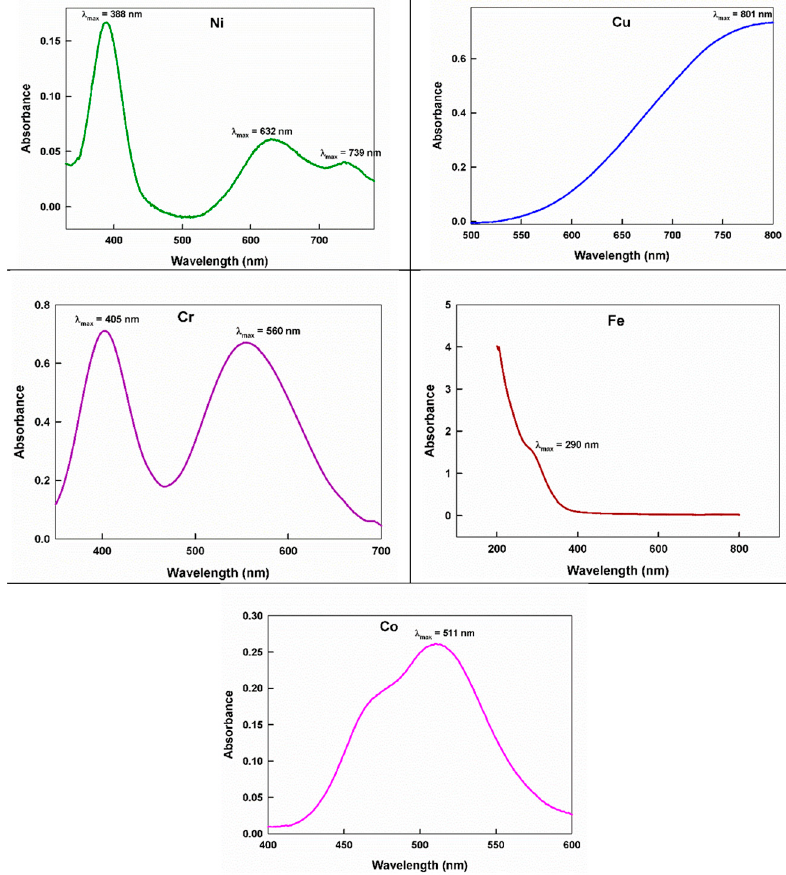
Figure 2. The UV-Vis spectrum of some of the coordination Figure 2 . The UV-Vis spectrum of some of the coordination oligomers .